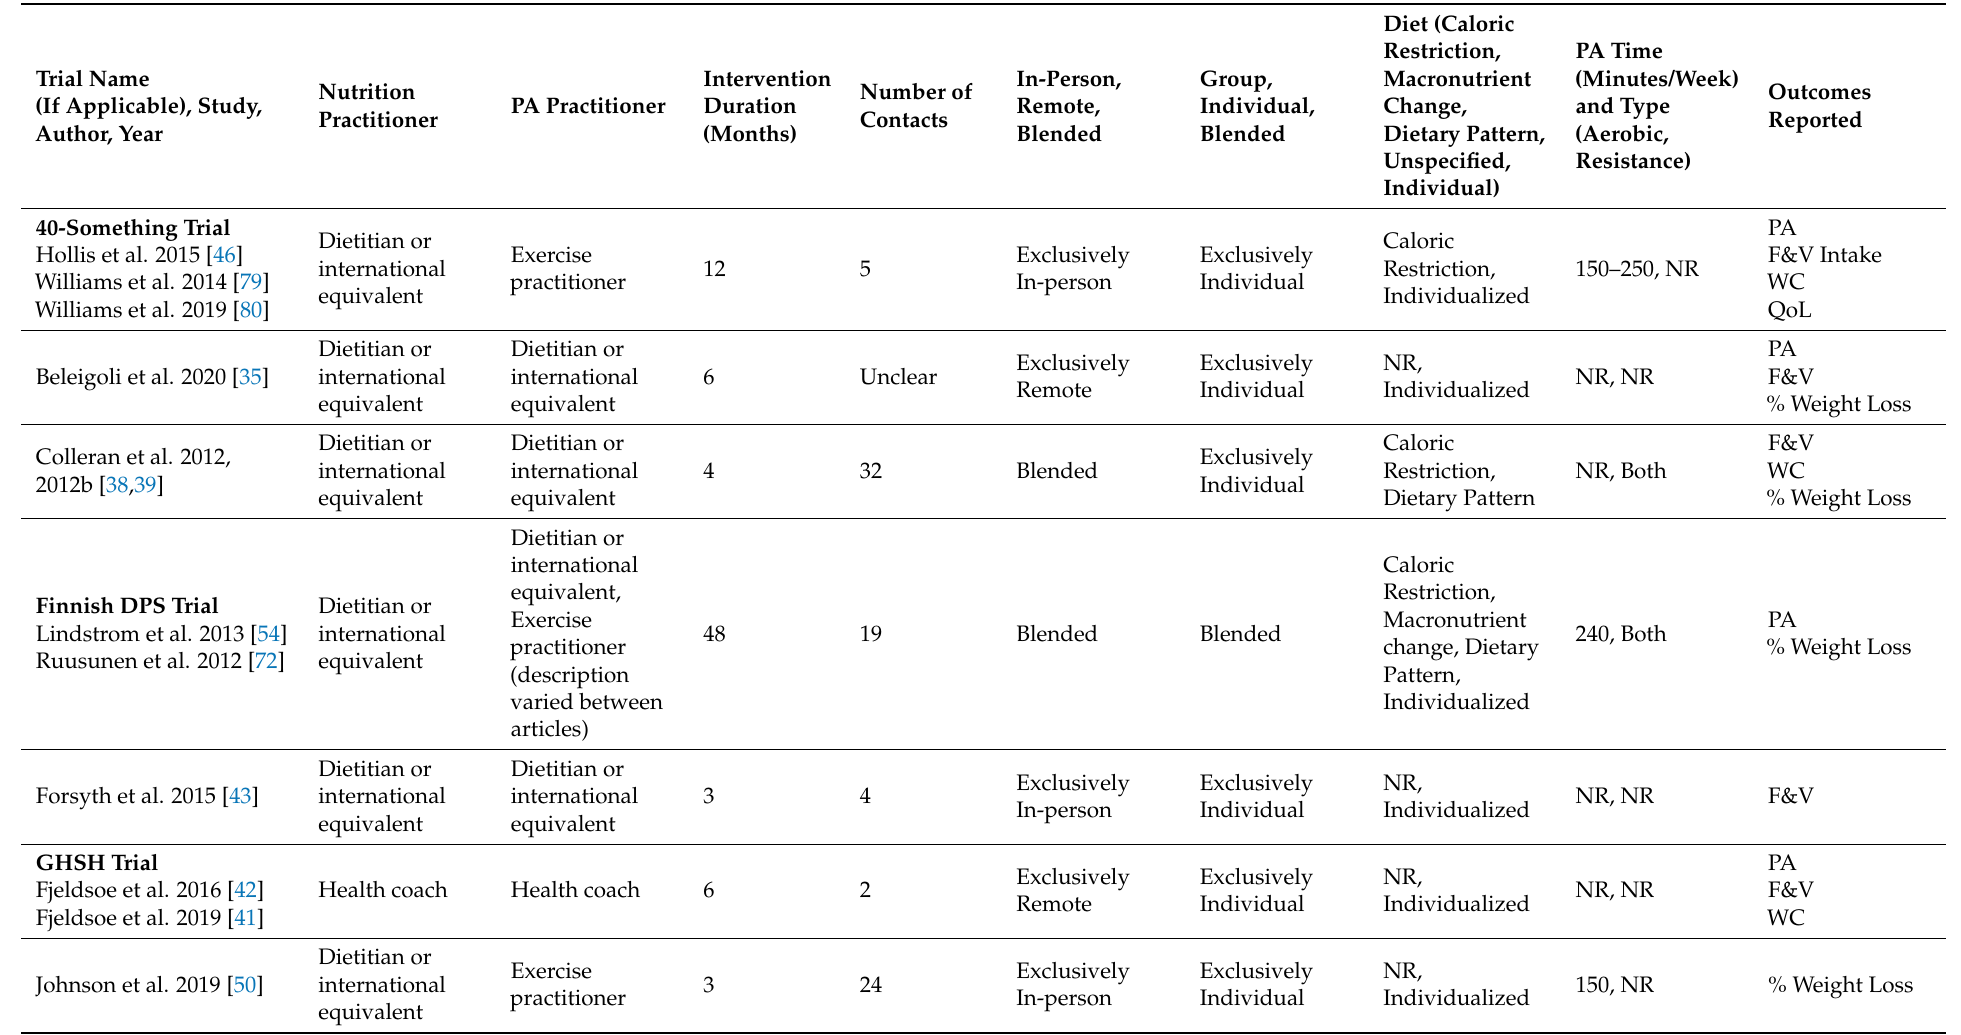
Table 3. Intervention characteristics of randomized controlled trials included in the systematic review examining effect of nutrition and physical activity interventions provided by nutrition and exercise practitioners for the general